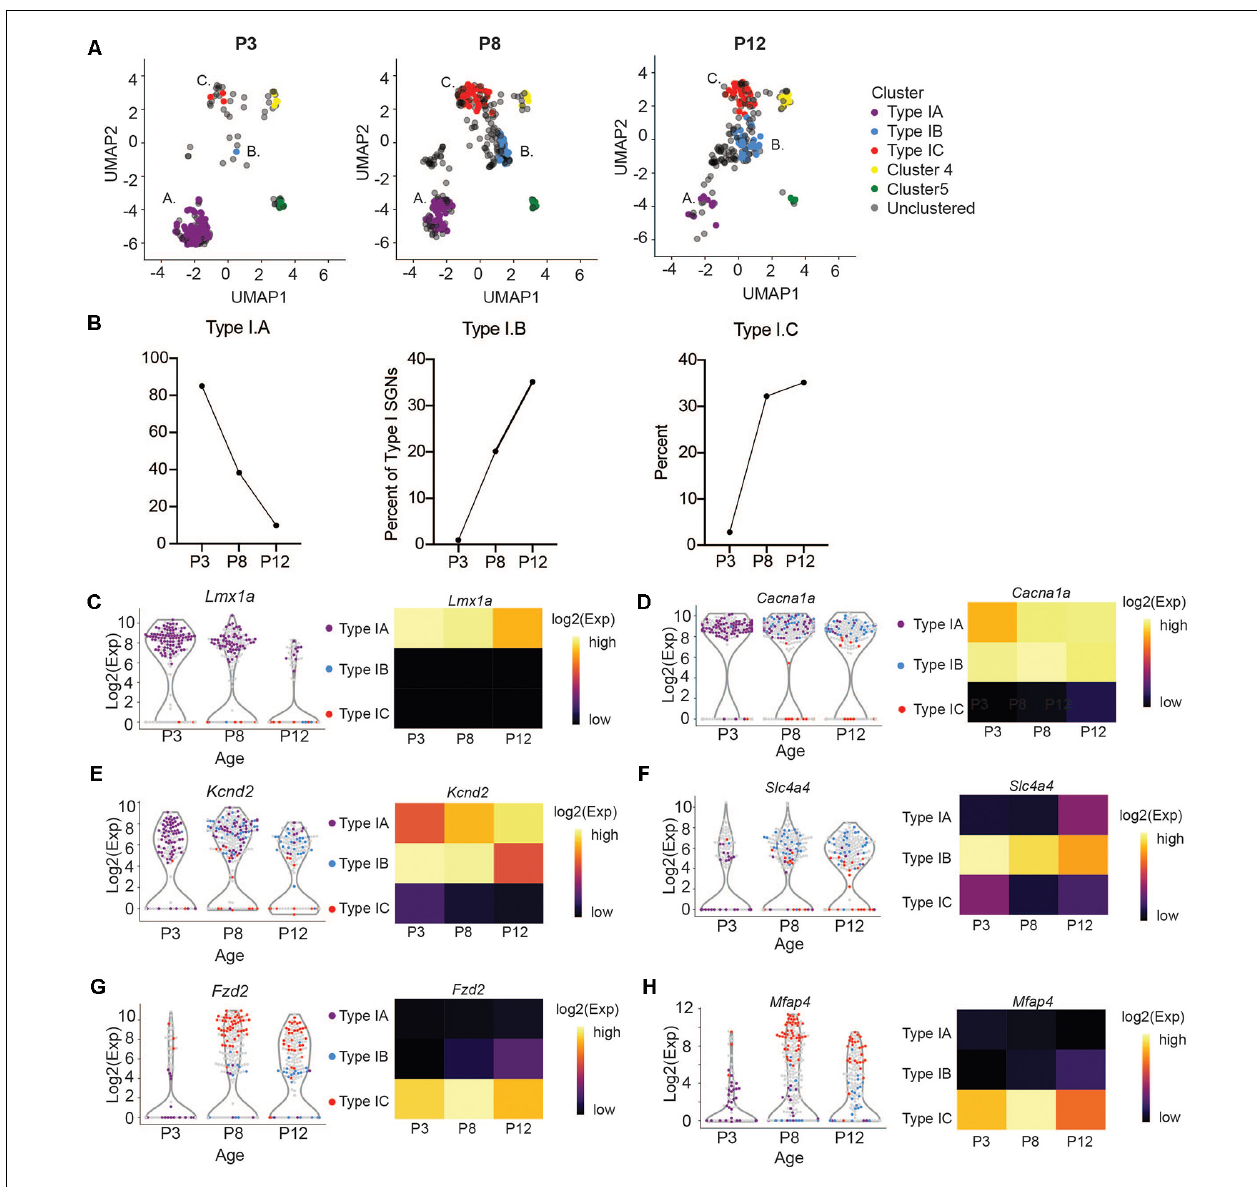
FIGURE 4 | Subtypes of Type I change in abundance at the onset of hearing. (A) UMAP projections of Type I SGNs colored by subtypes at postnatal days 3, 8, and 12 ( n = 203 single cells at P3 and n = 230 single cells at P12, representing three independent technical runs, each with four to six animals). Postnatal day 8 is reproduced from Figure 3A for clarity. (B) Quantification of the percentage of Type IA, IB, and IC cells as a fraction of the total Type I SGNs at each age. (C–H) Violin plot of (C) Lmx1a , (D) Cacna1a , (E) Kcnd2 , (F) Slc4a4 , (G) Fzd2 , (H) Mfap4 . Each point represents a single cell, colored according to its subtype or gray if outside the IA, IB, IC. On the right, a heatmap of the same data. The expression scale is giving on the right